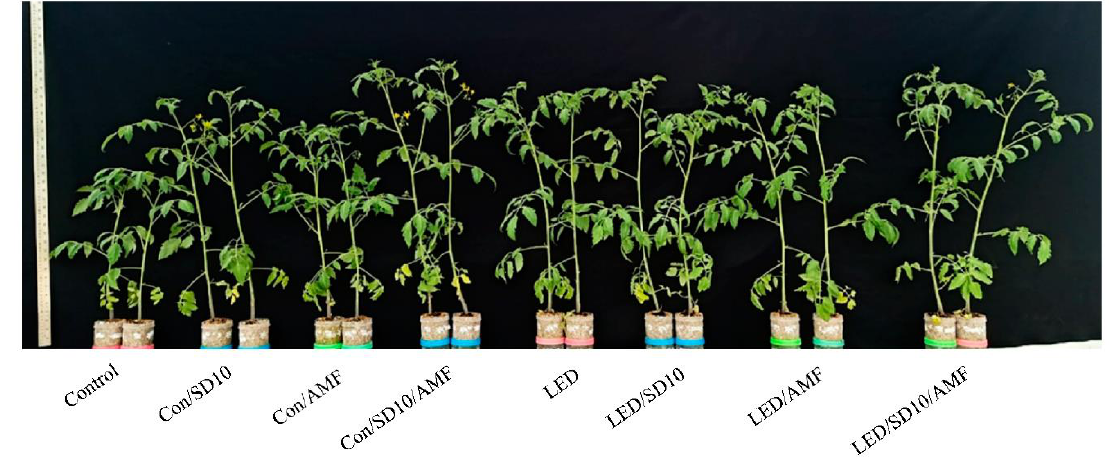
Figure 7. Tomato seedling phenotype after PGPR inoculation and AMF’s effect on the seedling growth stage under greenhouse conditions. Tomato plants at 30 days old after the seedling stage. Table 3.